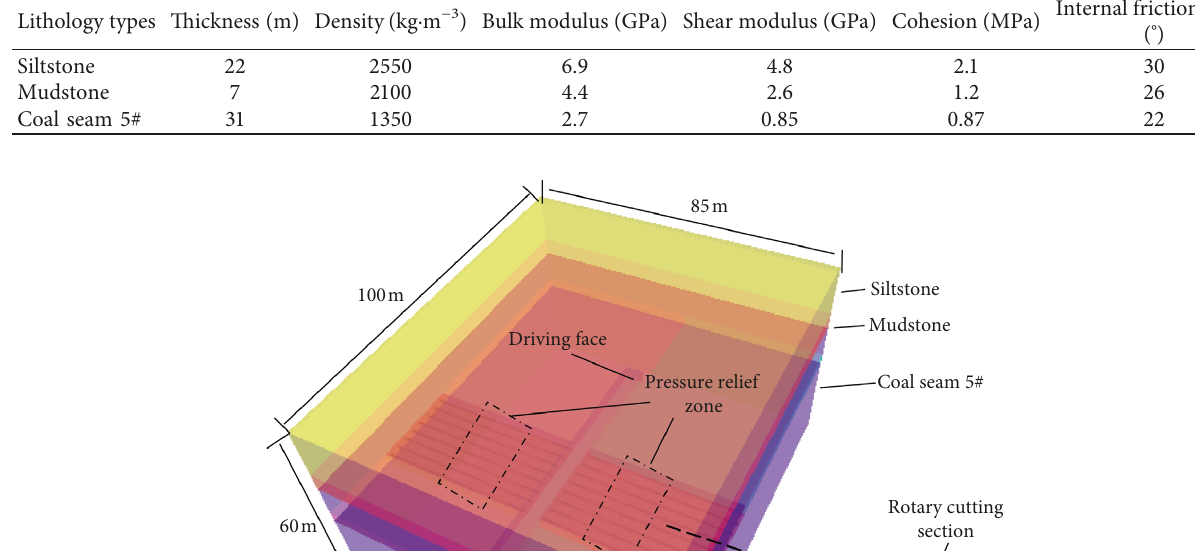
Table 5: The test results of physical and mechanical parameters.